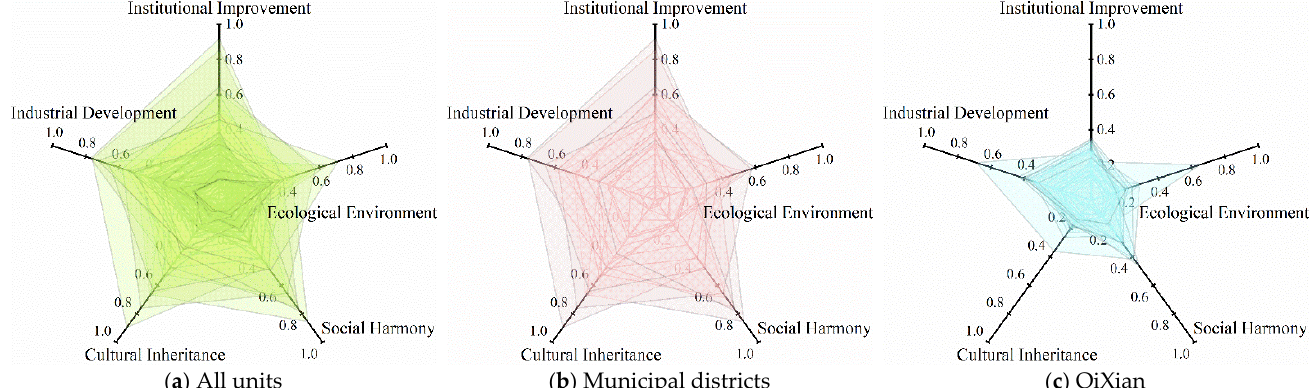
Figure 7. The results of Beautiful Inner Mongolia construction evaluation for the different types of administrative units: ( a ) all administrative units; ( b ) municipal districts; ( c ) QiXian.